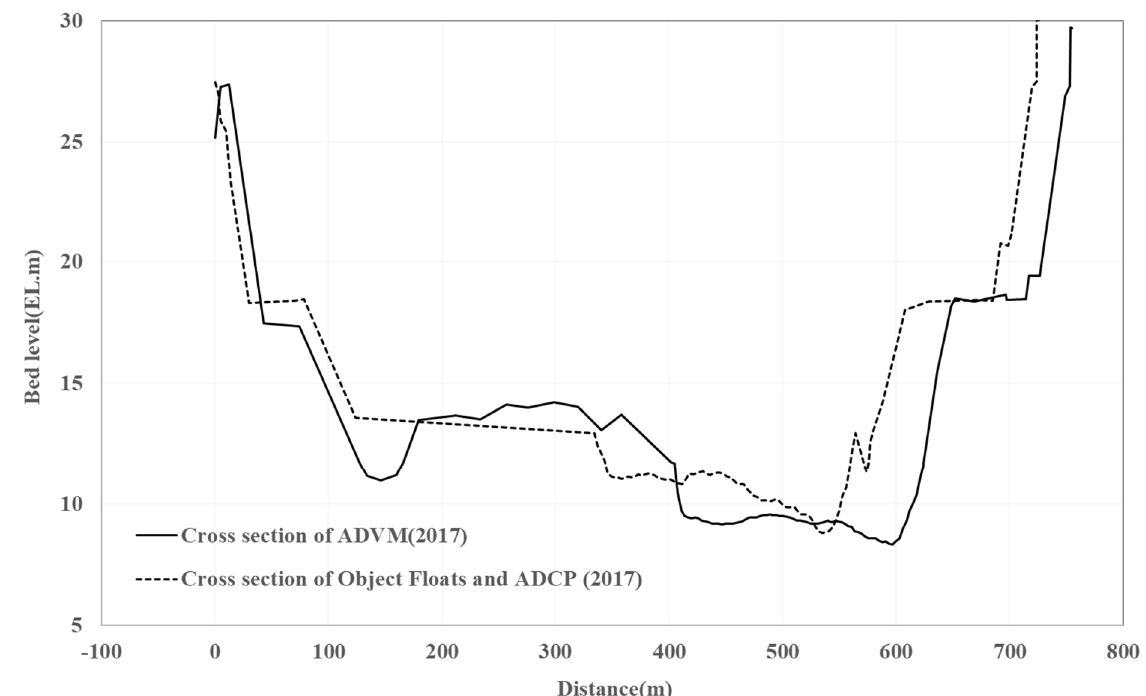
Figure 2. Cross sections of measuring discharge. Table 1. Location and specifications of the gauging station.